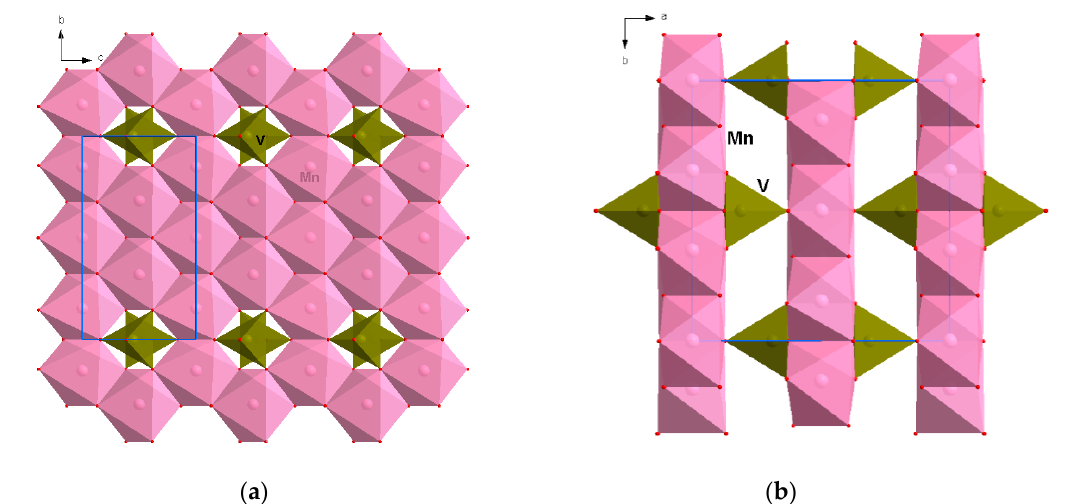
Figure 1. The crystal structure of reppiaite, Mn 5 (OH) 4 [VO 4 ] 2 in yz ( a ) and xy ( b ) projections.